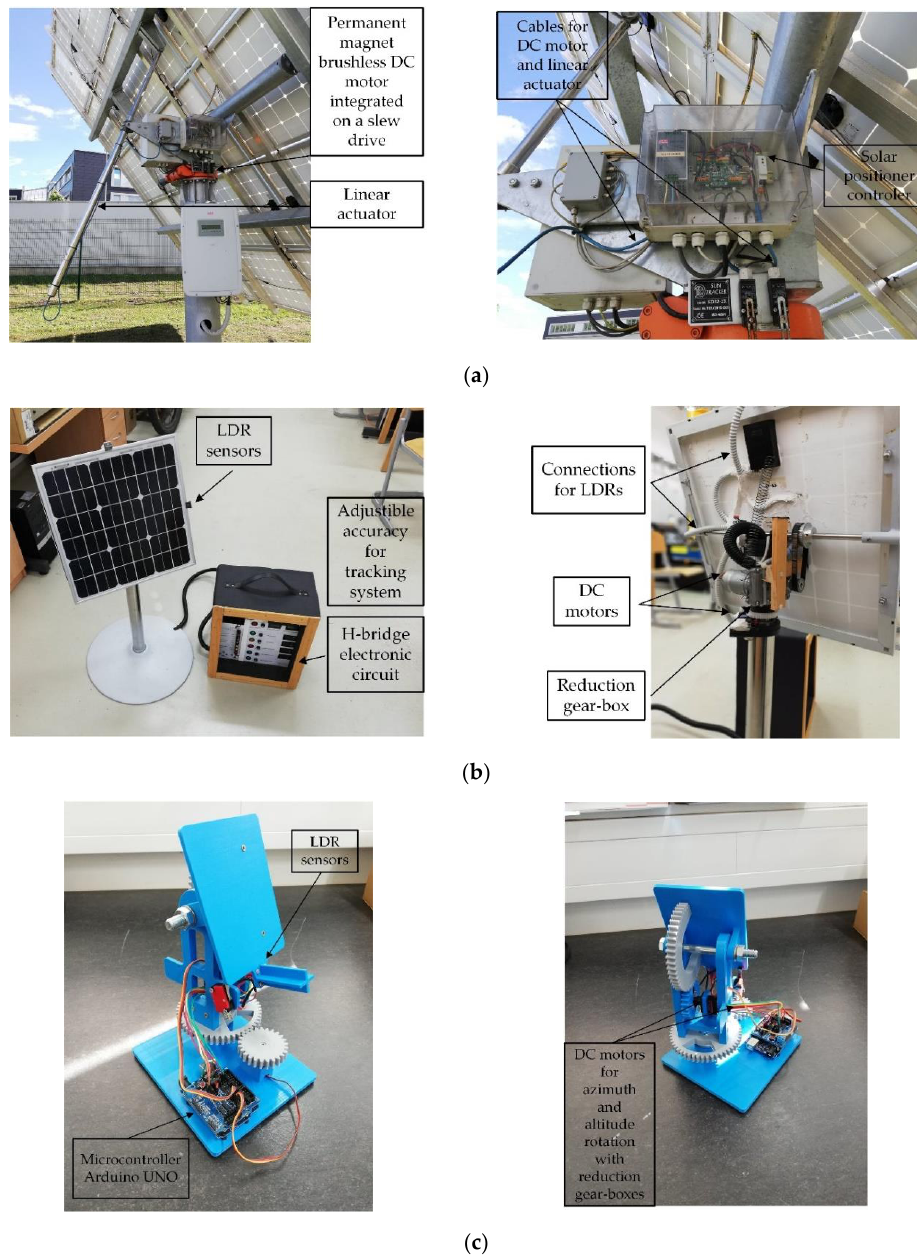
Figure 10. Different examples of ( a ) open-loop and ( b ), ( c ) closed-loop dual-axis tracking systems. Large-scale PV tracking systems (see Figure 10a) are those systems (commercial) that are connected to the grid and produce electrical energy. Their powers range from a few kWp to a few MWp of installed power. Large-scale PV tracking systems are most often used in the literature for analyses between different types of systems (comparison of fixed systems with single-axis and two-axis systems). Most often, researchers in the literature use medium-scale PV systems (see Figure 10b) for different research studies (comparison of different powertrains, control strategies, etc.,). In the literature, it is also possible to find small-scale PV tracking (see Figure 10c) systems, which are low-cost and are intended for educational purposes (training toolkits) in higher education institutions.